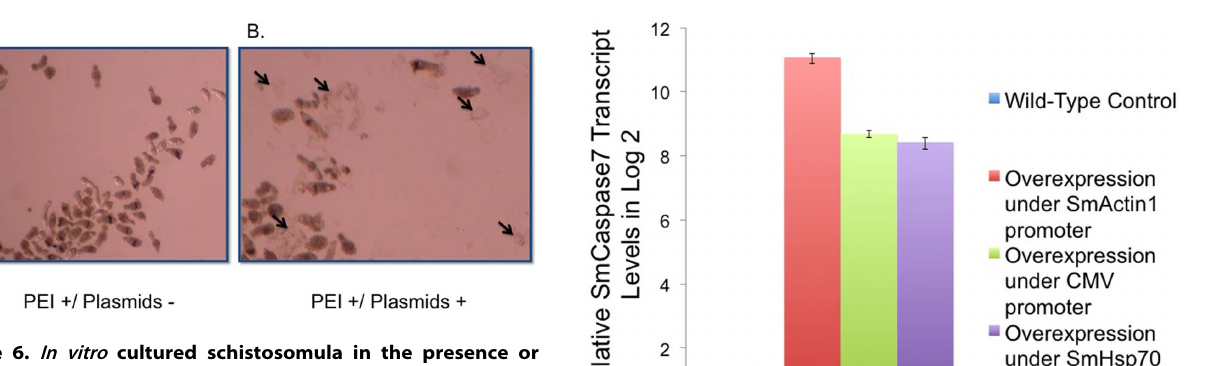
Figure 6. In vitro cultured schistosomula in the presence or absence of SmCaspase7 expression plasmids. Parasites were incubated in a total volume of 2 mL Basch Complete Medium at 37 u C and 5% CO 2 for 60 h. Larvae showing dark and opaque in the images may still be alive and are motile when observed under a light microscope. Only parasites displaying a complete loss of motility or a distinctive loss of morphological integrity were considered dead. (A) Schistosomula were cultured in complete Basch medium with PEI agent alone. After 60 h, most parasites were still alive. Similar results were observed with samples treated with DNA constructs alone (data not shown) or samples treated without any transfection agent (wild-type). (B) Schistosomula were incubated with both PEI and plasmid constructs expressing SmCaspase7 under control of the SmActin1 promoter. Overexpression of the SmCaspase 7 gene in schistosomula caused